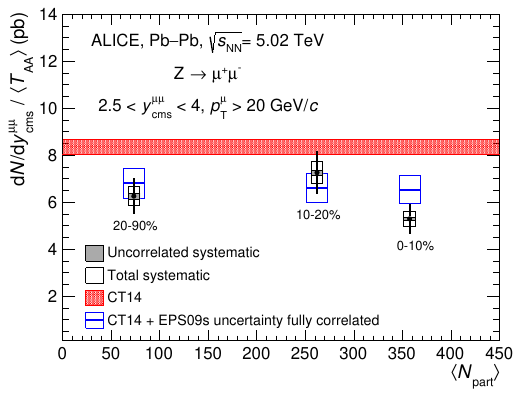
Figure 5 . Invariant yield of Z ! (cid:22) + (cid:22) (cid:0) divided by h T AA i in the rapidity range 2 : 5 < y (cid:22)(cid:22) < 4 : 0 cms p for three centrality classes in Pb-Pb collisions at s NN = 5 : 02 TeV. The uncorrelated systematic uncertainties are reported as (cid:12)lled boxes. The open boxes indicate the quadratic sum of correlated and uncorrelated systematics. The results are compared with the free-nucleon PDF prediction (CT14 [50]) and with calculations with the centrality-dependent EPS09s nPDFs [56].